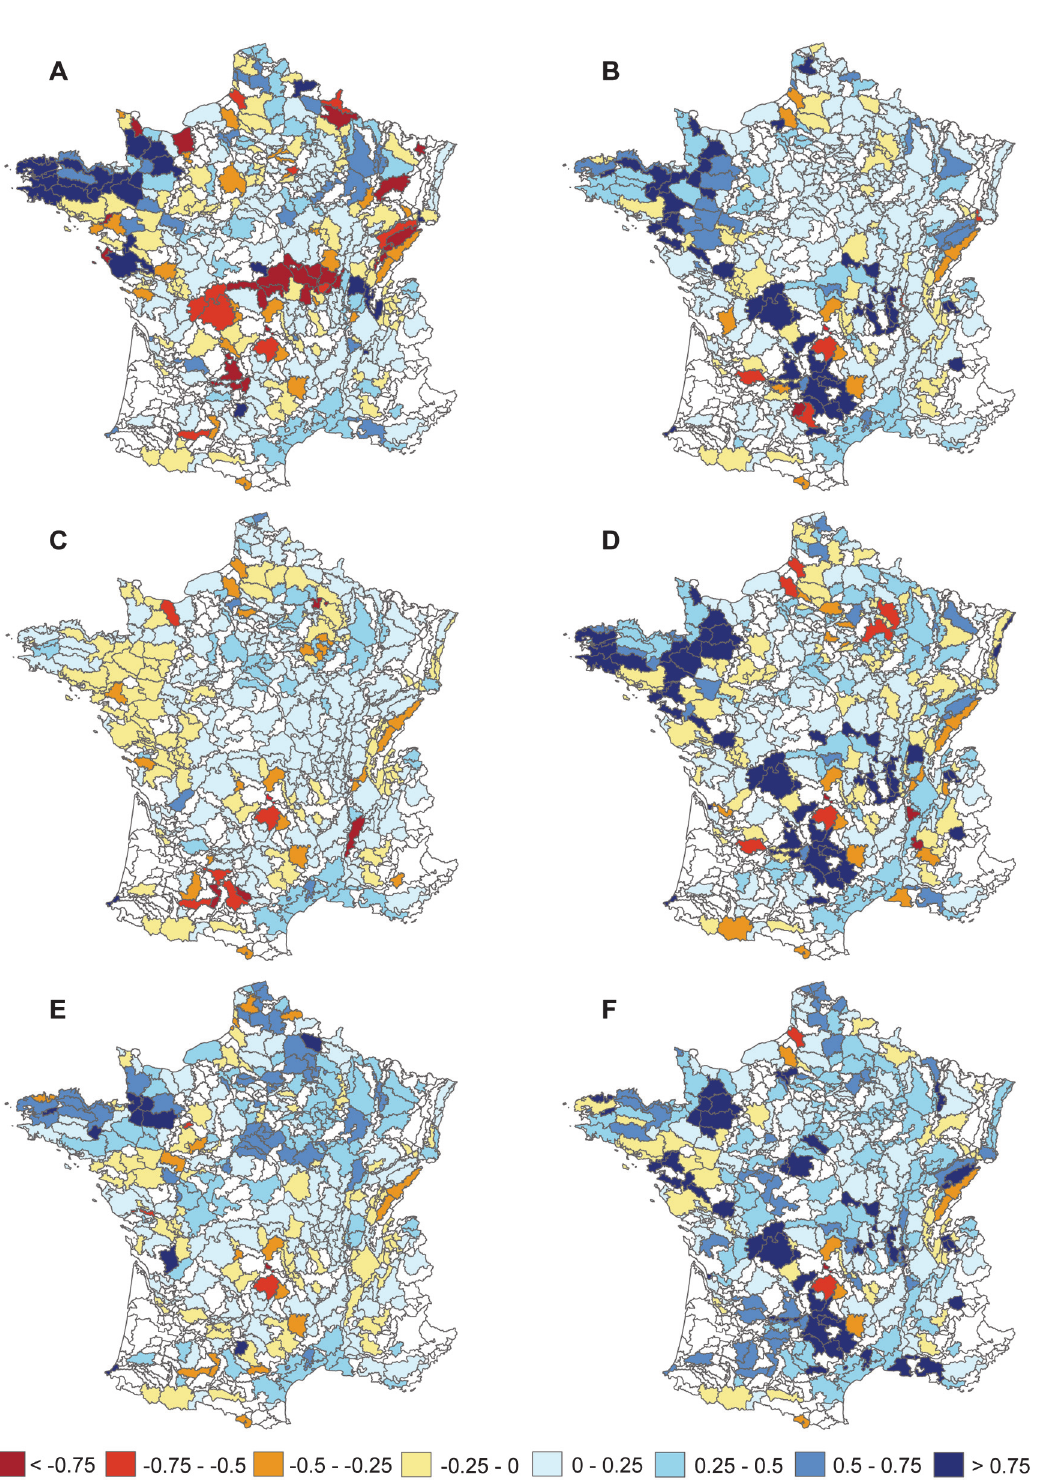
Fig 5. Predicted regional responses of Whinchat Saxicola rubetra to the different scenarios. Percent change in regional abundance of the Whinchat (one of the grassland specialist species) in response to the different land cover scenarios: A) ‘ status quo ’ , B) ‘ livestock extensification ’ , C) ‘ global biofuel ’ , D) ‘ regional biofuel ’ , E) ‘ global extensification ’ and F) ‘ regional extensification ’ , all combined to climate and land use change scenarios. The more red it is the more abundance decreases.